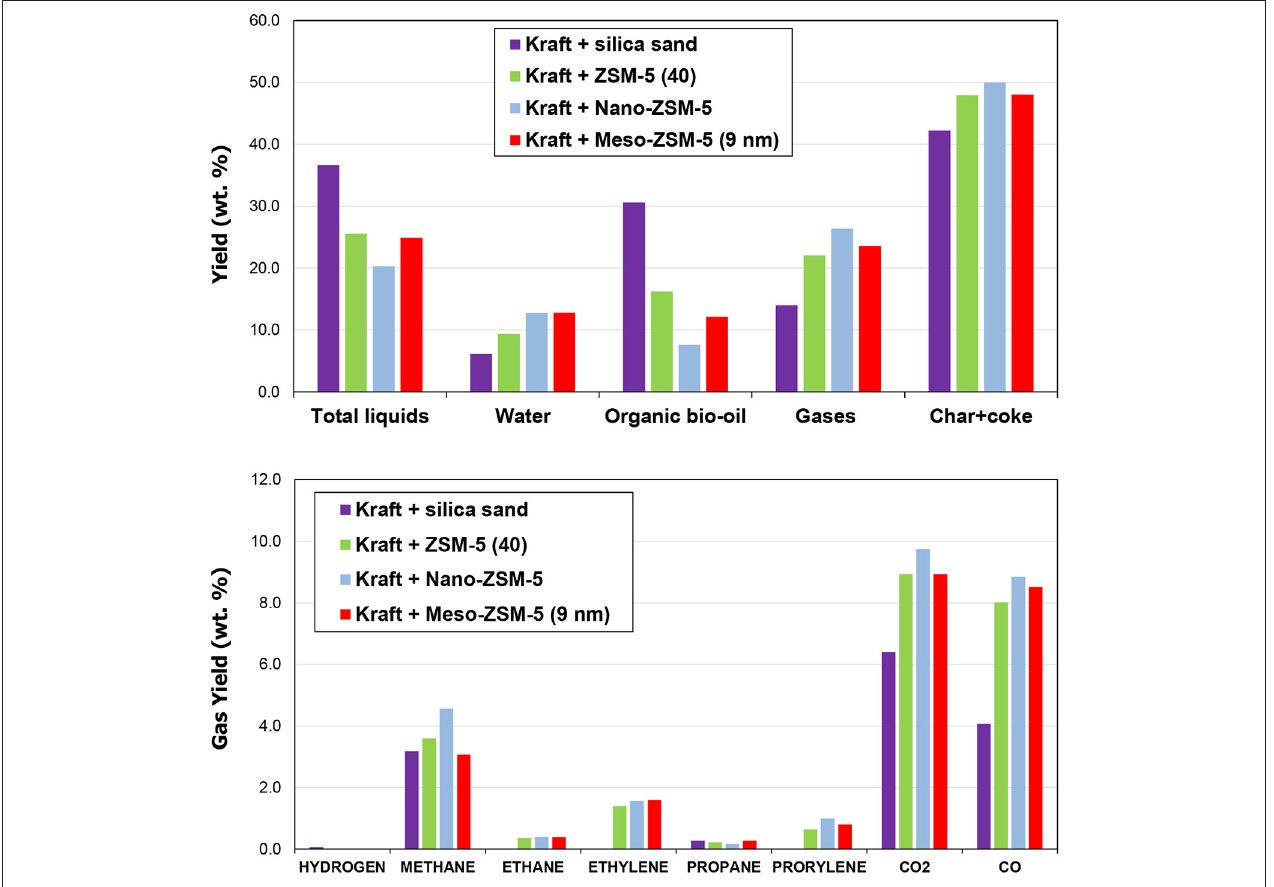
FIGURE 11 | Product yield distribution and gas analysis from the thermal and catalytic fast pyrolysis of kraft lignin (results from the fixed bed